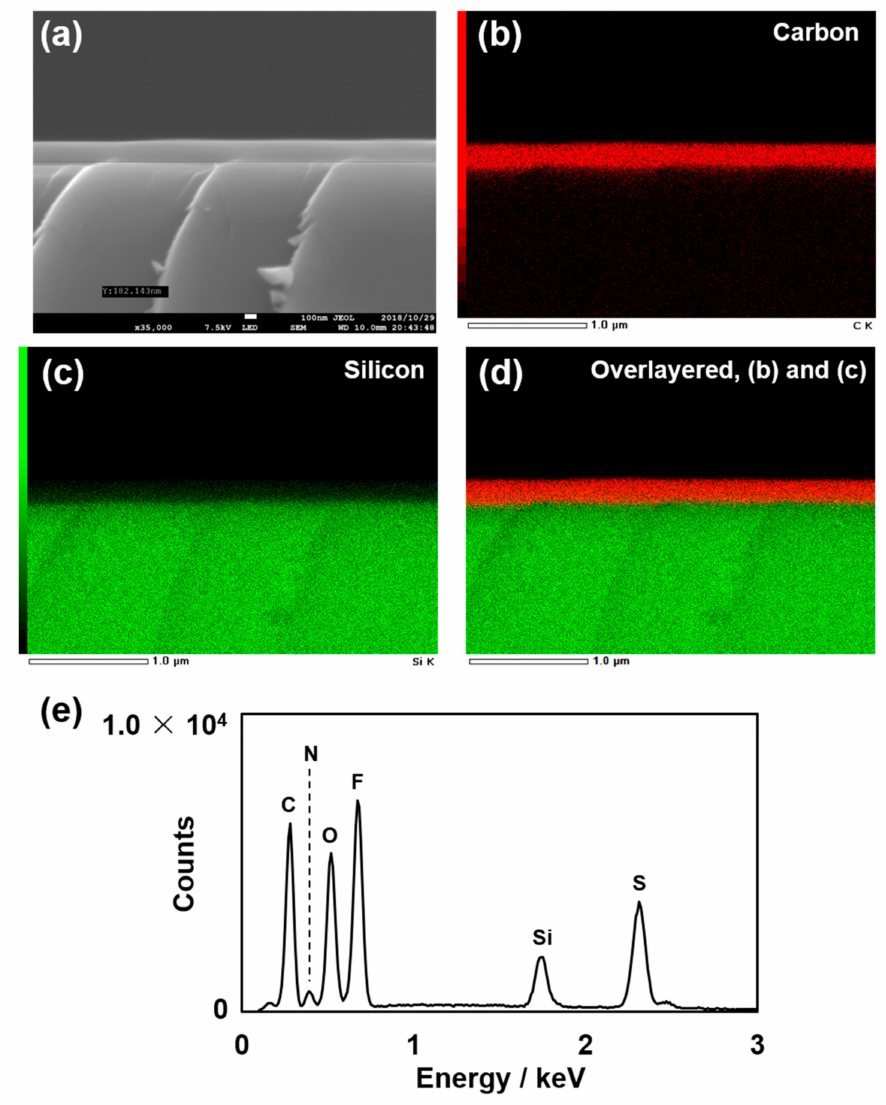
Figure 4. Scanning electron microscopy (SEM)–energy-dispersive X-ray spectroscopy (EDX) analysis of the product. The upper regions of the images are empty, whereas the lower regions are the inner part of the silicon wafer. All images shown were taken in the same field: ( a ) cross-sectional SEM images of the surface of poly( N , N -diethyl- N -(2-methacryloylethyl)- N -methylammonium bis(trifluoromethylsulfonyl)imide) (DEMM–TFSI) on the silicon wafer; ( b ) elemental map of carbon; ( c ) elemental map of silicon; ( d ) over-layered image of ( b ) and ( c ); and ( e ) EDX spectrum of the surface of in situ concentrated polymer brush (CPB) grafted on the silicon wafer. In ( e ), each letter suggests the elements identified by EDX: C, carbon (0.28 keV); N, nitrogen (0.39 keV); O, oxygen (0.53 keV); F, fluorine (0.68 keV); Si, silicon (1.74 keV); and S, sulfur, (2.31